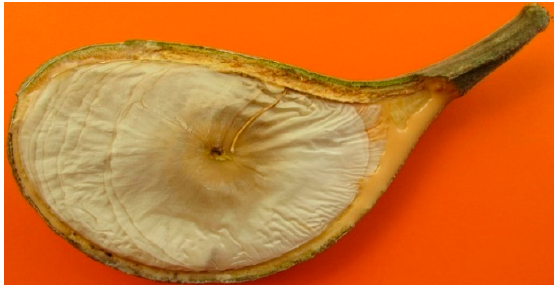
Figure 2. Orbicular seed of Aspidosperma spruceanum Benth. ex Müll.